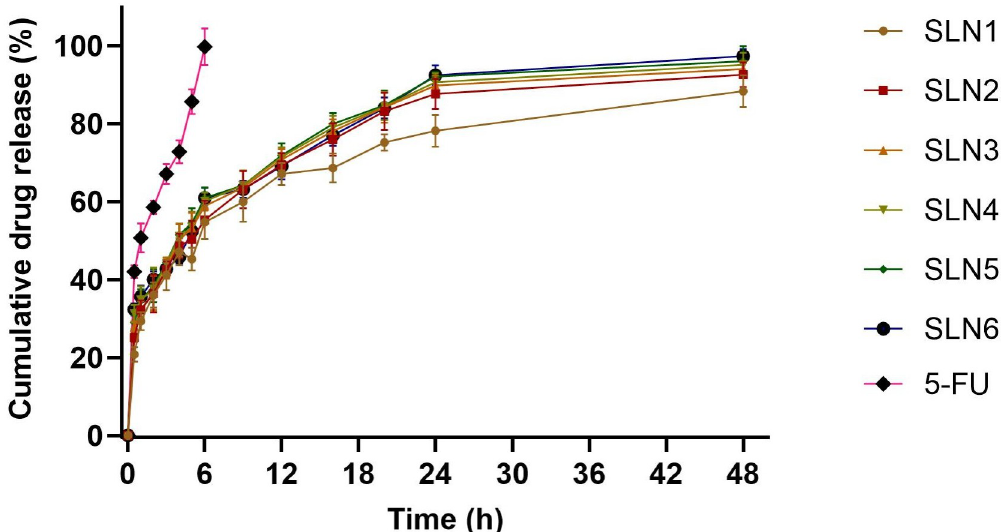
Fig 5. The in-vitro release profile of 5-FU and 5-FU-loaded SLNs in PBS pH 7.4. All results indicate mean ± SD, n = 3, and p < 0.05.